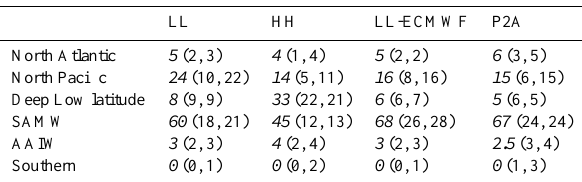
Table 3. Percentage contribution of each tagged water mass to the upper ocean volume (above the 26.8 isopycnal) between 30 ◦ S and 30 ◦ N in italic lettering. Listed in parentheses are the percentage contributions of unmodified tagged phosphate (first number) and the remineralized tagged phosphate (second number) to the total phos- phate inventory above the 26.8 isopycnal. The columnwise sum of the unmodified and remineralized contributions (both numbers in parentheses) should be close to 100% of the total phosphate reser- voir. However, some columns may sum to less than 100% due to roundoff error and because part of the Bay of Bengal is only par- tially